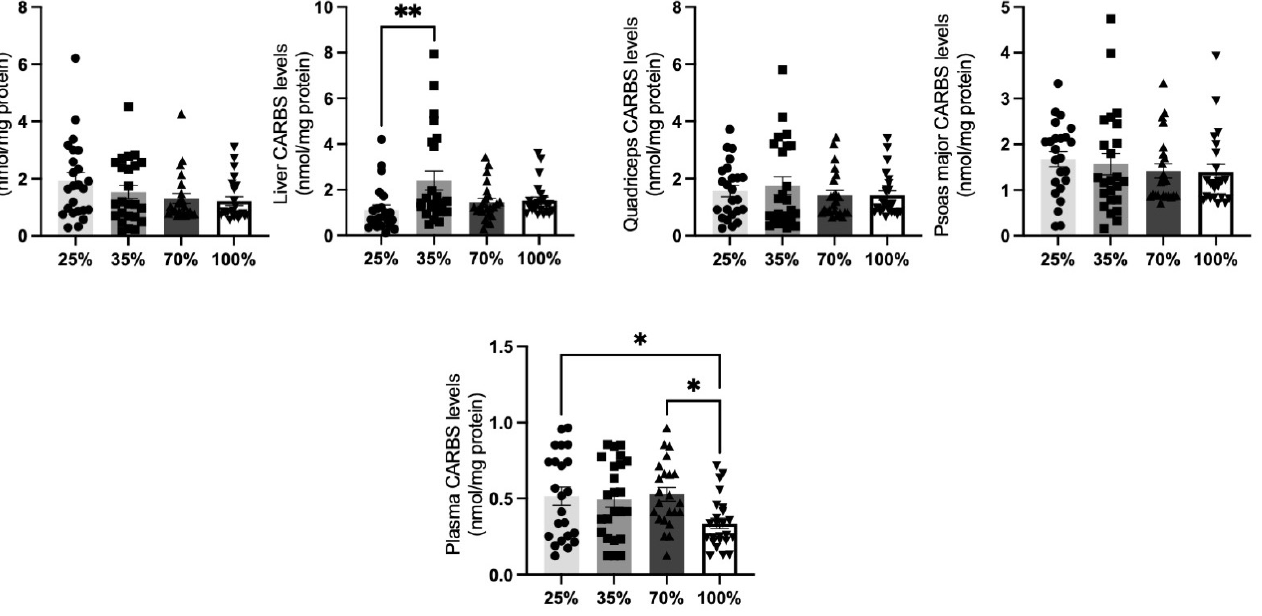
Figure 2. CARBS levels at all 4 d.s. of lambs . * denotes significant difference with p < 0.05, ** denotes significant difference with p < 0.01.